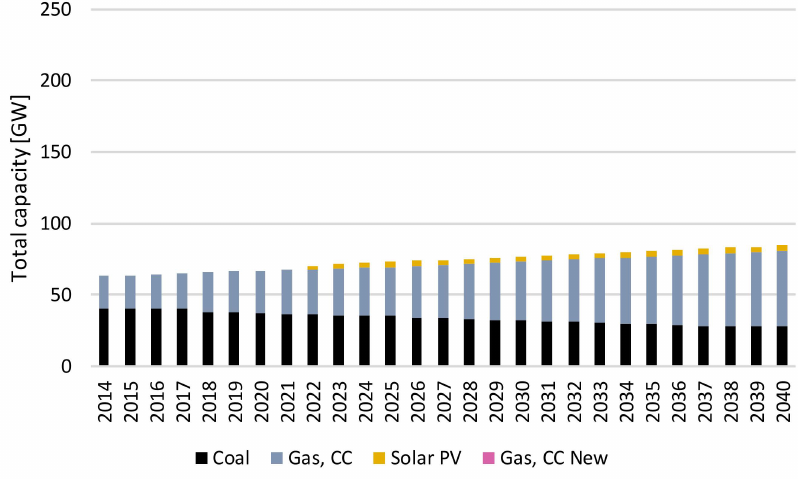
Figure 3. Total capacity (GW) in the REF scenario—without code